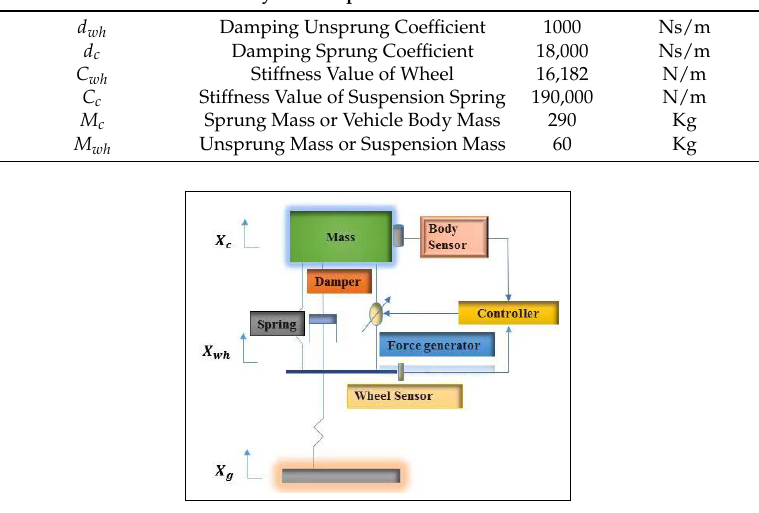
Figure 1. Active suspension system [29].